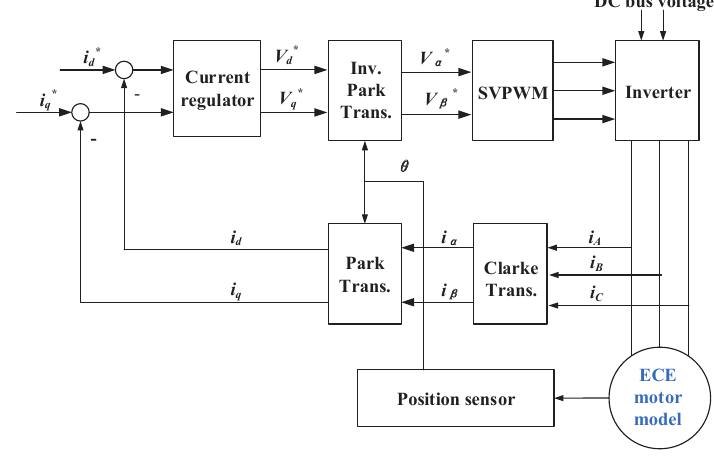
Figure 6. Illustration of Model